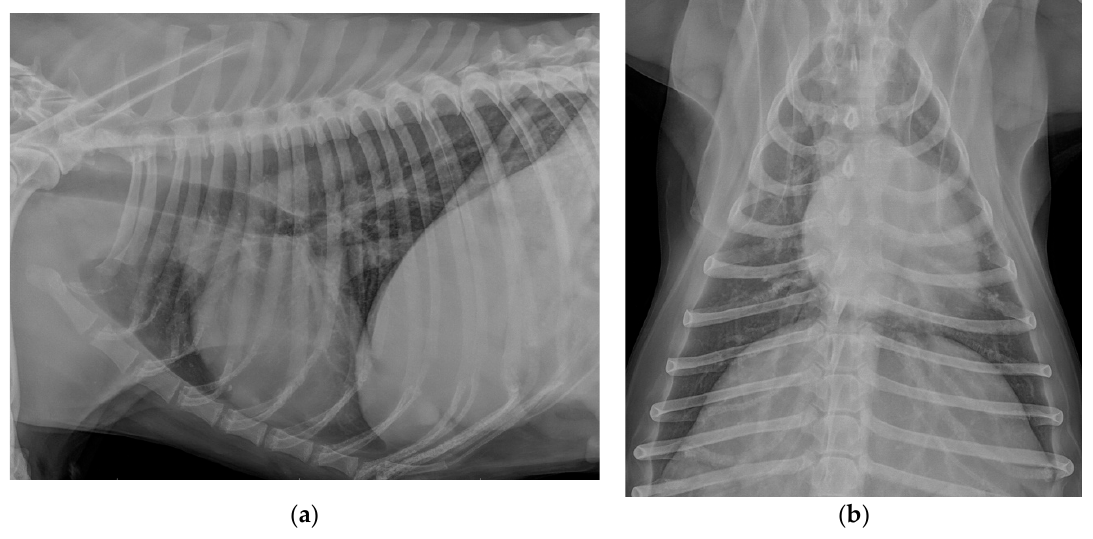
Figure 1. Radiographic examination of the thorax of the dog affected by intracardiac porcupine quill migration. ( a ) Left lateral and ( b ) ventrodorsal projections show no abnormalities.